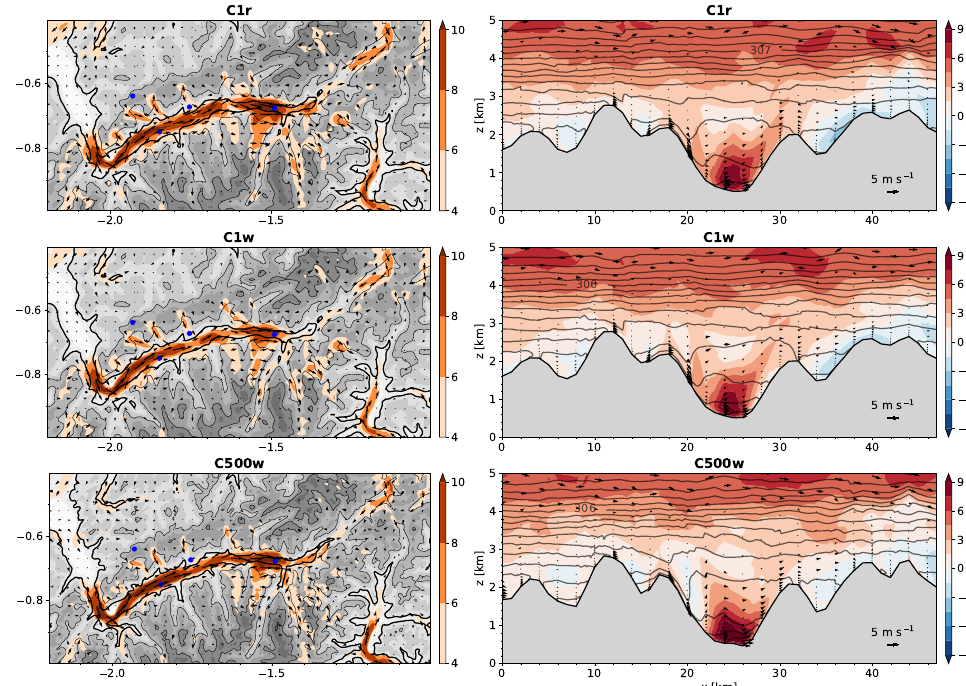
Figure 10. Snapshot of the flow pattern on 23 September 2016 at 16:00 for three different simulations. ( Left column) Wind speed (shading) and direction (vectors) at ca. 200 m AGL (10th model level); ( Right column) Along- valley wind component normal to the cross-section (shading), potential temperature (black contours), and cross-valley wind (vectors; wind component parallel to the cross- section) in a vertical cross section through Sion (see Figure